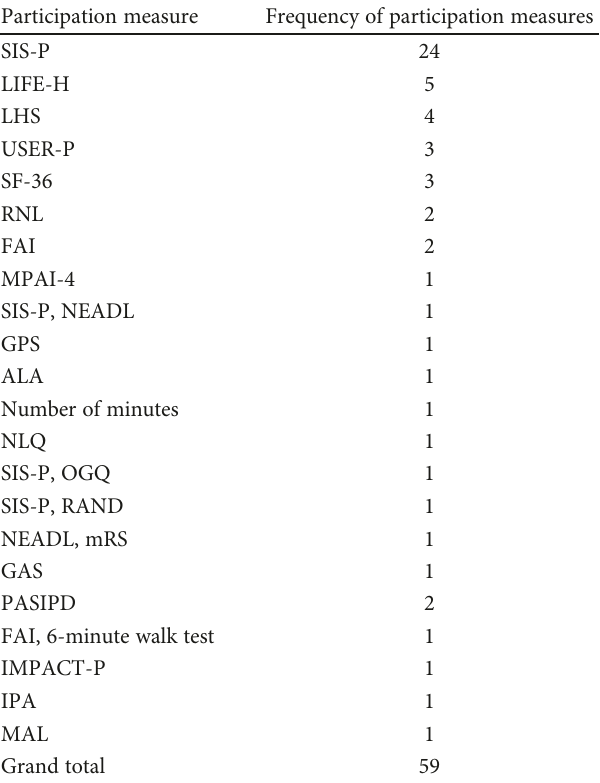
Table 5: Tools measuring participation longitudinally after stroke. Table 6: De fi nitions of participation reported by authors measuring participation longitudinally after